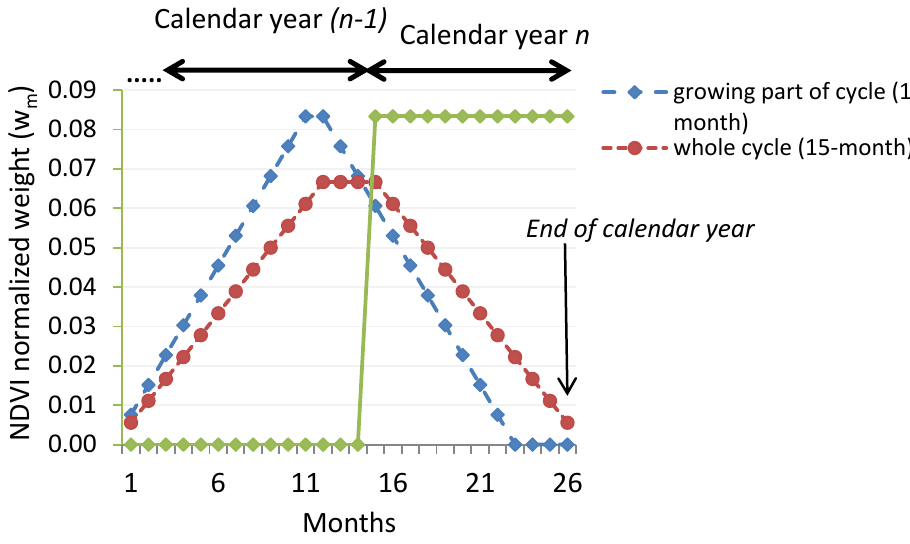
Figure 3. Three sets of weights used to calculate time integration of monthly NDVI values for annual yield estimation (year n ). The green line (between months 14 to 26) corresponds to weights generally used to calculate the annual NDVI (the calendar year corresponding to the yield measurement). The blue and red lines correspond to weights that take into account the sugarcane cropping calendar (15 months for the whole cycle, and 11 months for the growing period) in the NDVI time